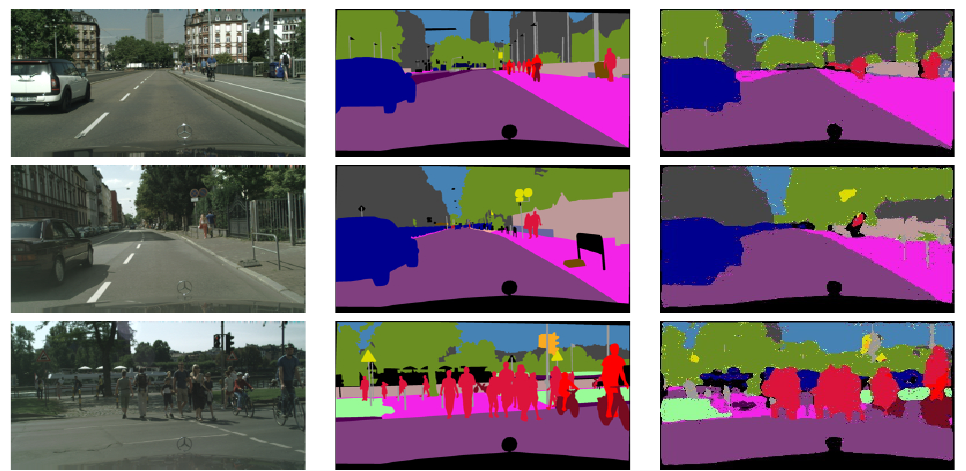
Figure 16. Representative successful Cityscapes images: source images ( left ), GT ( center ), and results ( right ).